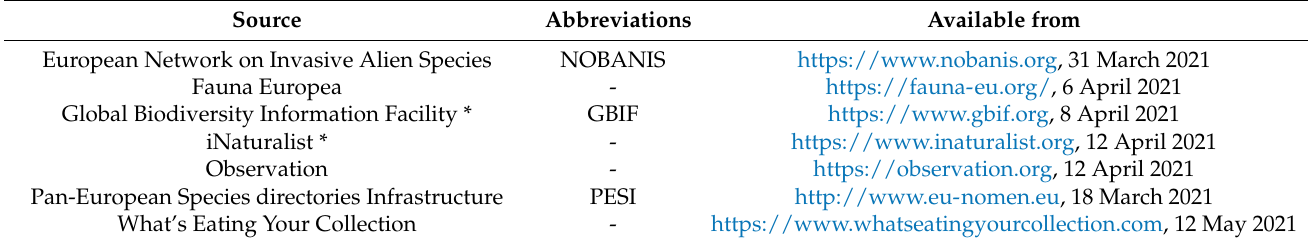
Table 1. The public sources surveyed within monitoring the occurrence of Ctenolepisma longicaudatum in Europe. Source Abbreviations Available from European Network on Invasive Alien Species NOBANIS Fauna